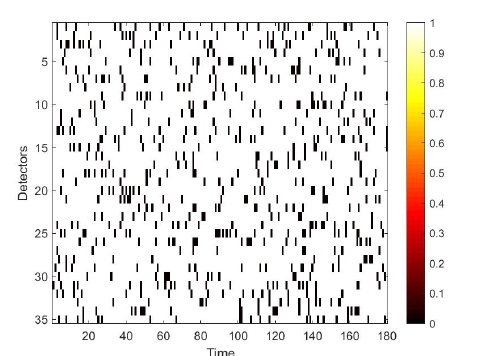
Figure 8. Mask used to simulate discrete damage.